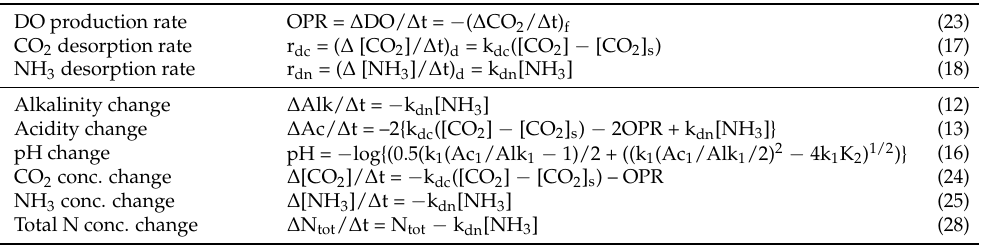
Table 2. Equations to calculate the rates of processes and change of variable concentrations in sequencing batch polishing ponds.